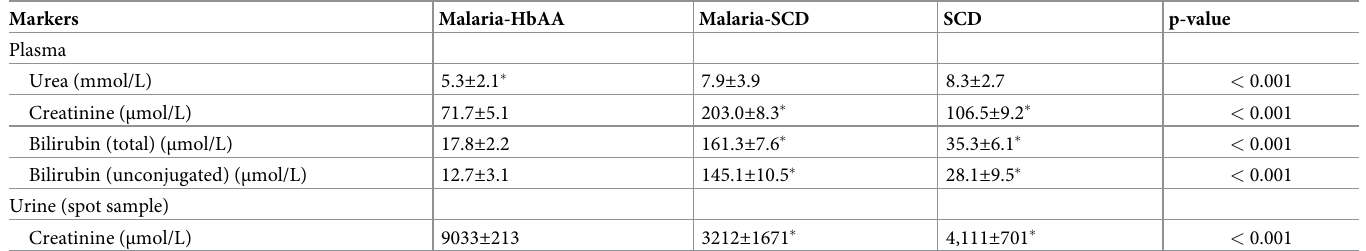
Table 7. Urea, creatinine and bilirubin levels in the study participants.